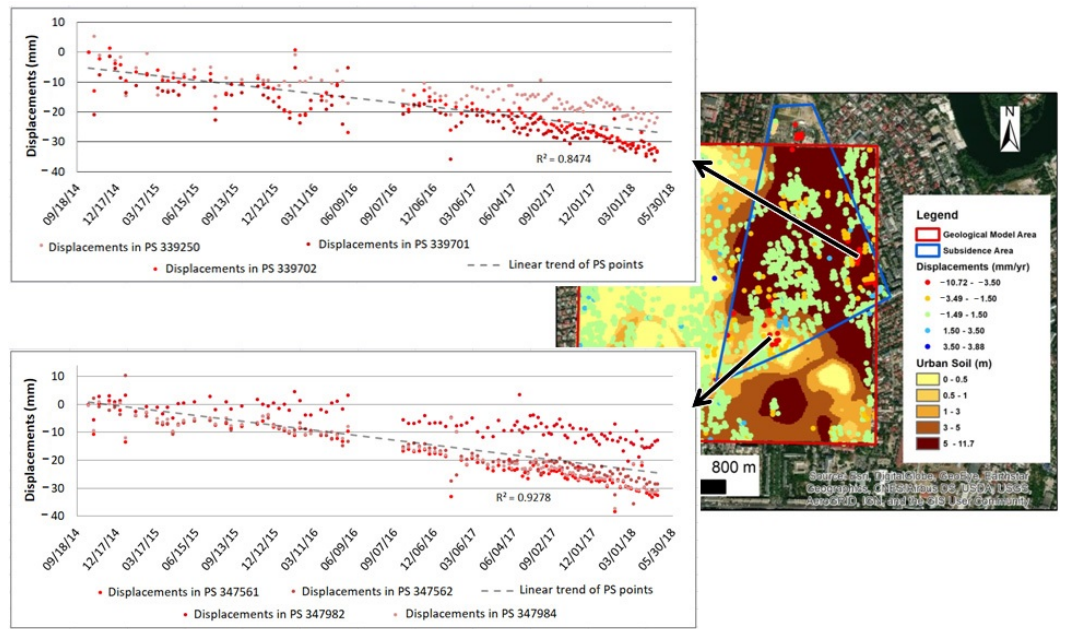
Figure 10. PSI displacement trends in Barbu Vacarescu area. The graphs show the displacements in mm ( y -axis) of selected points over time ( x -axis). Accumulated subsidence for both selected areas is approximately − 35 mm subsidence over a 4-year time period.